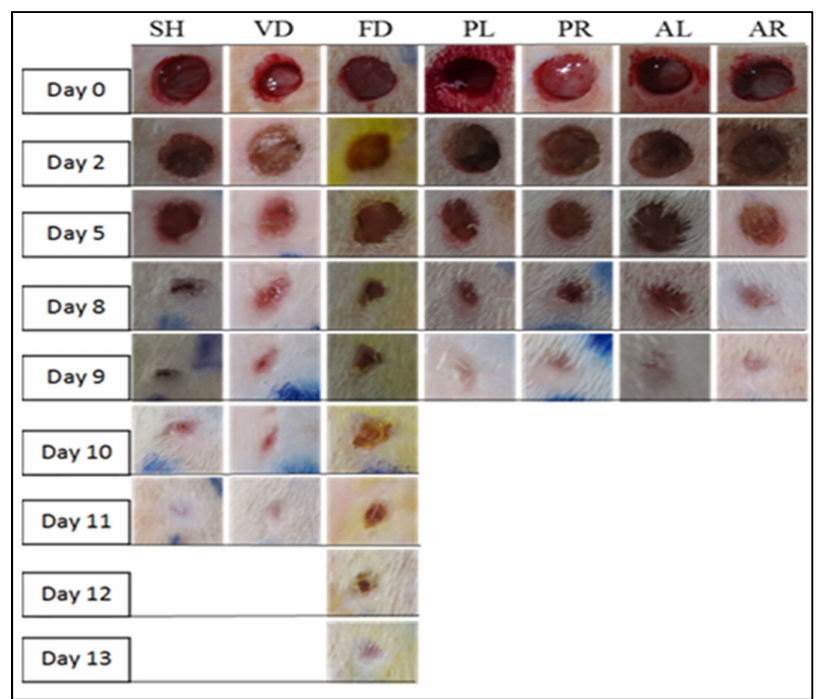
Figure 2. Macroscopic view of wounds of seven normal male rat experimental groups: SH, VD, FD, PL, PR, AL and AR on day 0, 2, 5, 8, 9, 10, 11, 12 and 13. SH: sham control group (without treatment), VD: treated with vehicle (Cetomacrogol ointment), FD: treated with flavine (Acriflavine 0.1%), PL: treated with 1.0% concentration of MPvp leaves extract, PR: treated with 1.0% concentration of MPvp stem-roots extract, AL: treated with 2.0% concentration of MPva leaves extract, AR: treated with 2.0% concentration of MPva stem-roots